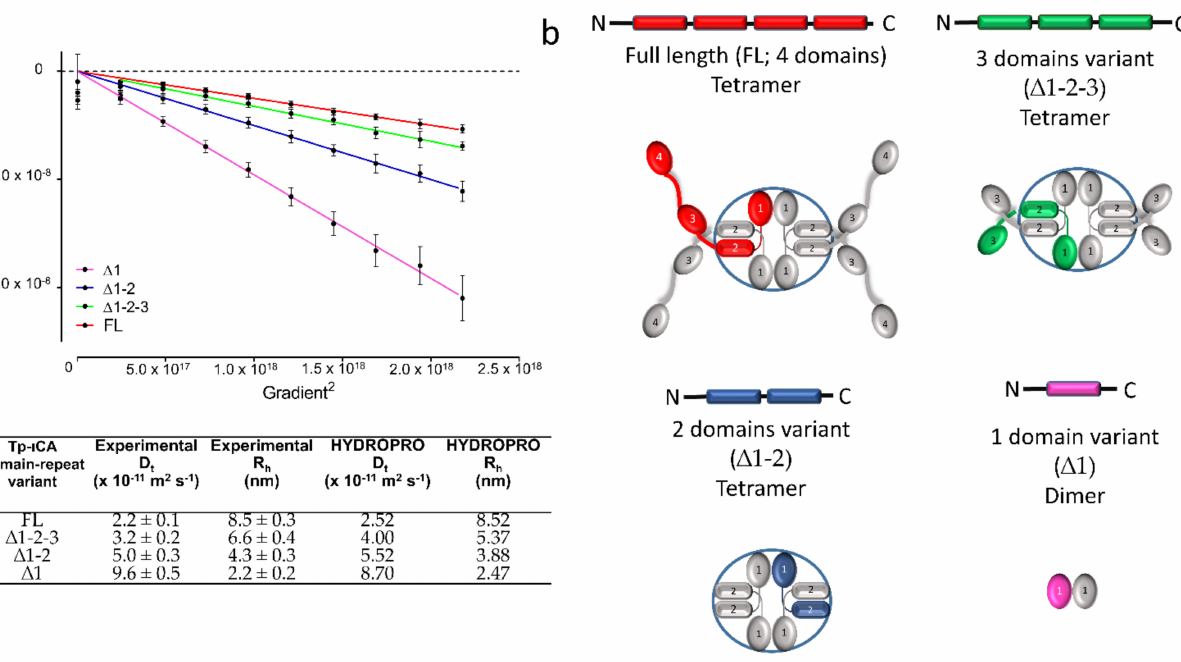
Figure 5. Domain organization of tp ι -CA. ( a ) Translational diffusion coefficient (D t ) of the different domain variants produced from the full-length (four domain-containing) tp ι -CA obtained from DOSY-NMR. Top : Logarithm of the NMR signal intensity as a function of the square of the gradient strength. Bottom : Table showing experimental D t for the inferred R h using the Stokes–Einstein relation as well as the computed D t and R h from the homology model using HYDROPRO software. The calculation for the full-length construct and the domain variant constructs ∆ 1-2-3 and ∆ 1-2 are performed on the tetrameric forms. The calculation of the domain variant ∆ 1 is performed on the dimeric form. ( b ) Schematic models of the different tp ι -CA domain variants from which the HYDROPRO calculation was performed. Only one monomer was colored in each